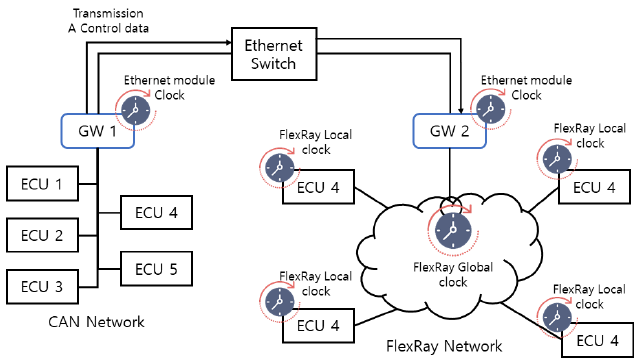
Figure 1. The communication between the controller area network (CAN) and FlexRay.